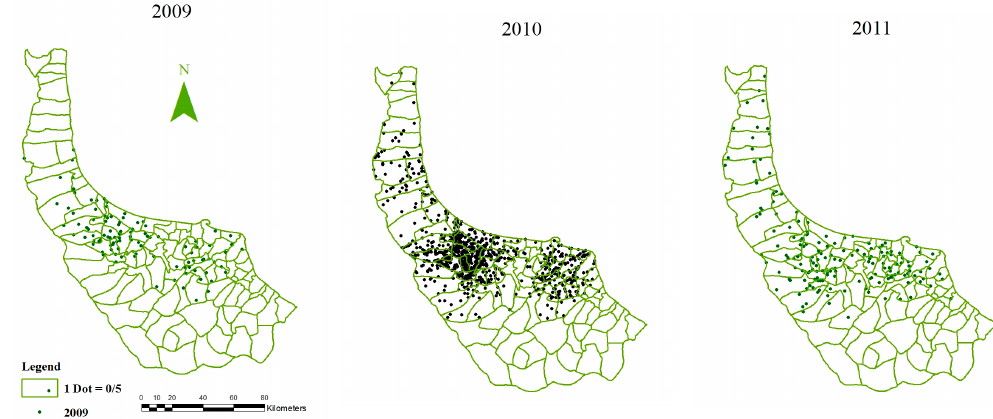
Figure 2. Incidence rates of leptospirosis in villages of Gilan.